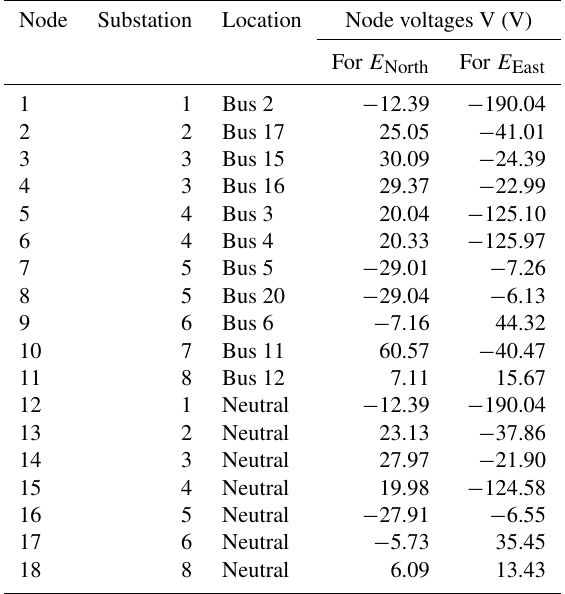
Table 7. Nodal voltages produced by northward and eastward elec- tric fields of 1Vkm − 1 .